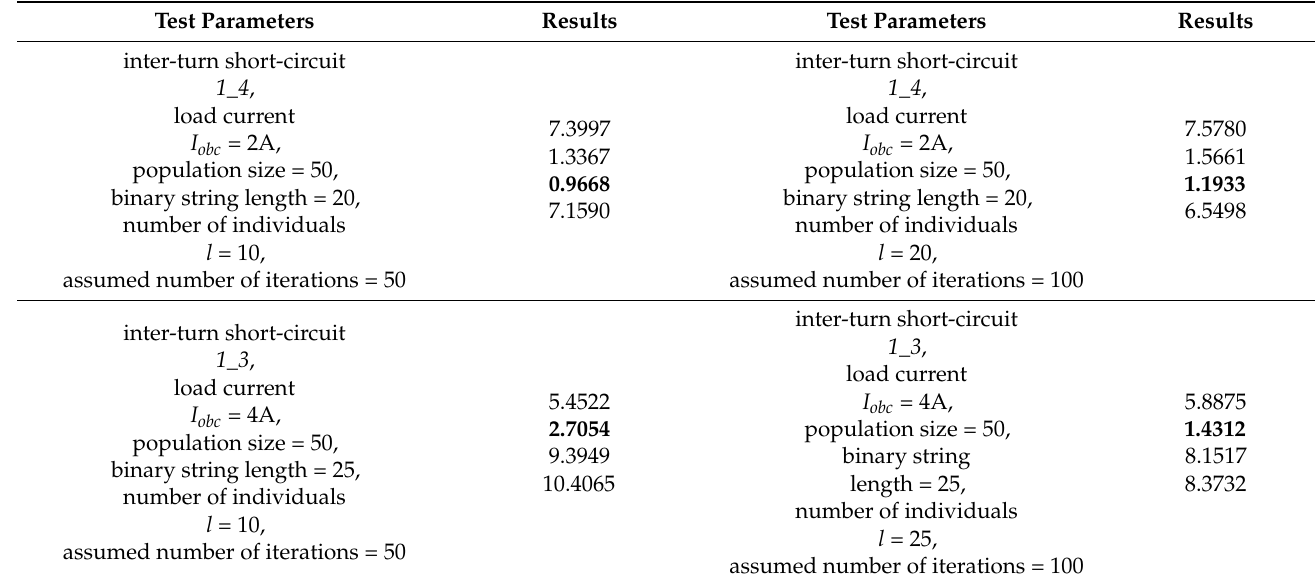
Table 3. Example results of matrix H 2 tests for signal proportional to axial flux φ 1 .